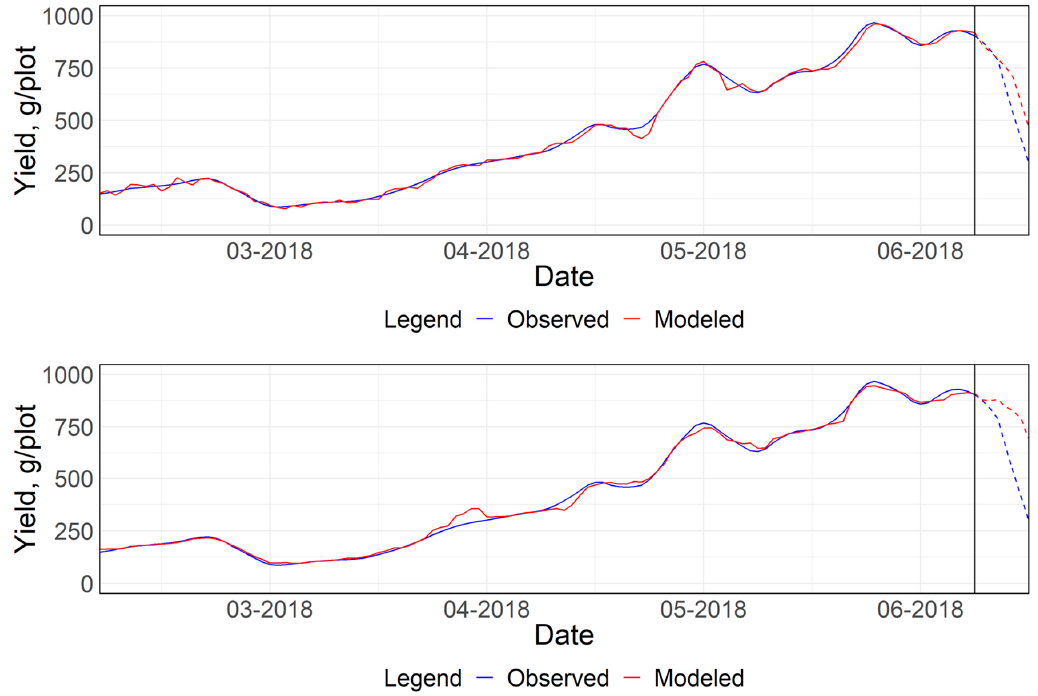
Figure 11. Time series plots of strawberry yield overlaid by approximations from NN ( top ) and RF ( bottom ). The vertical line separates the sample from the training and testing seven data points. Figure 10 included three scatter plots: the testing set (left), the best cross-validated set (center), and the corresponding trained model (right). The scatterplot shows that most of the points were